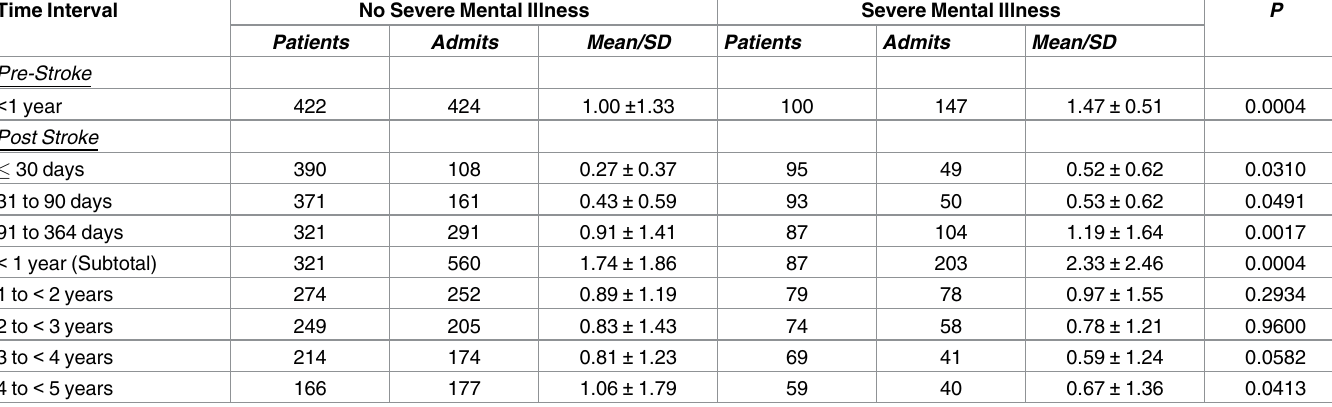
Table 3. Comparison of number and averageof non-psychiatric hospitalizations between living patients with and without severemental illness over